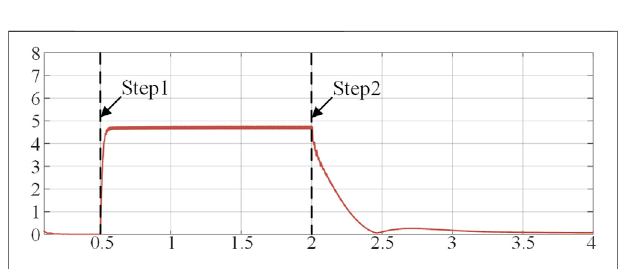
FIGURE 12 | The change of the PCC voltage